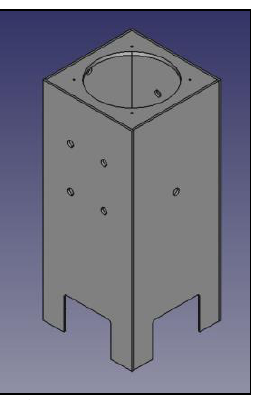
Fig. 17. 3D model of small laboratory cooling tower (height 700 mm).